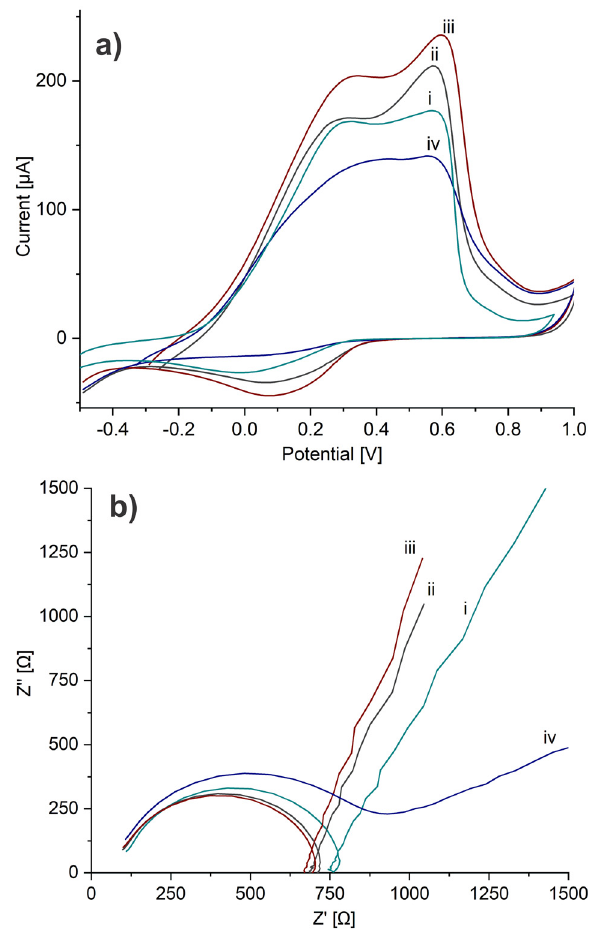
Figure 4: ( a ) Cyclic voltammetry and ( b ) electrochemical impedance spectroscopy of ( i ) SPCE/PAni, ( ii ) SPCE/PAni/AuNP, ( iii ) SPCE/PAni/ AuNP/cMWCNT, and ( iv ) SPCE/PAni/AuNP/cMWCNT/CAT